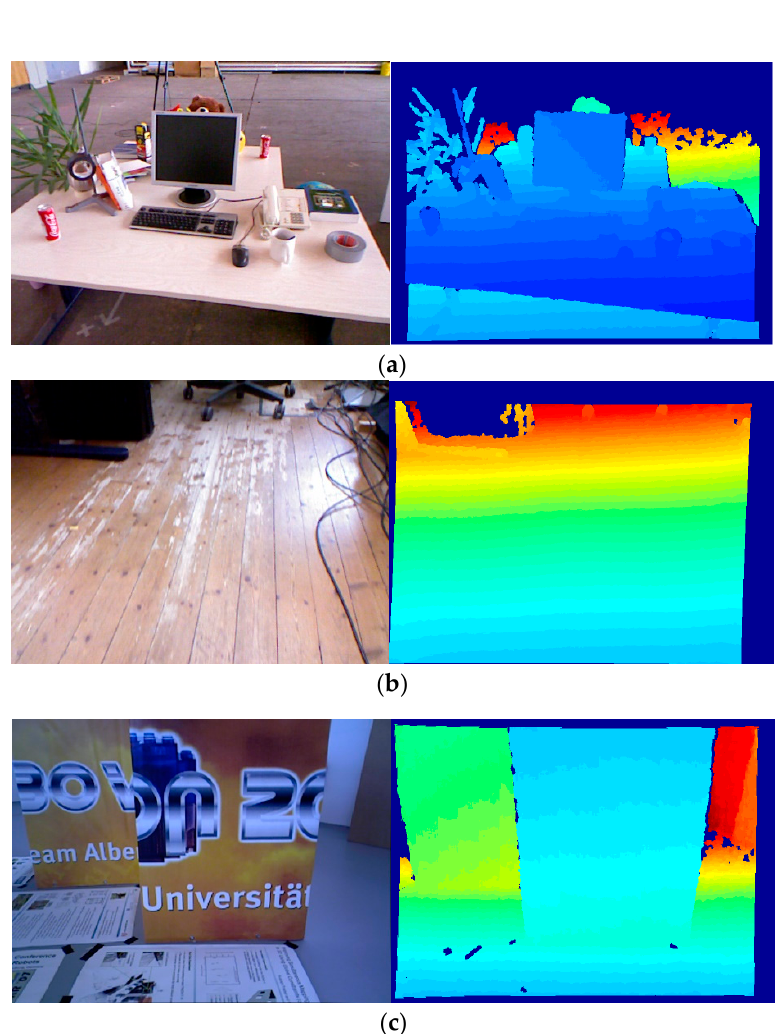
Figure 12. Images from three sequences of Freiburg dataset. ( a ) RGB image and depth image of Desk sequence ( b ) RGB image and depth image of Floor sequence ( c ) RGB image and depth image of structure texture far sequence.